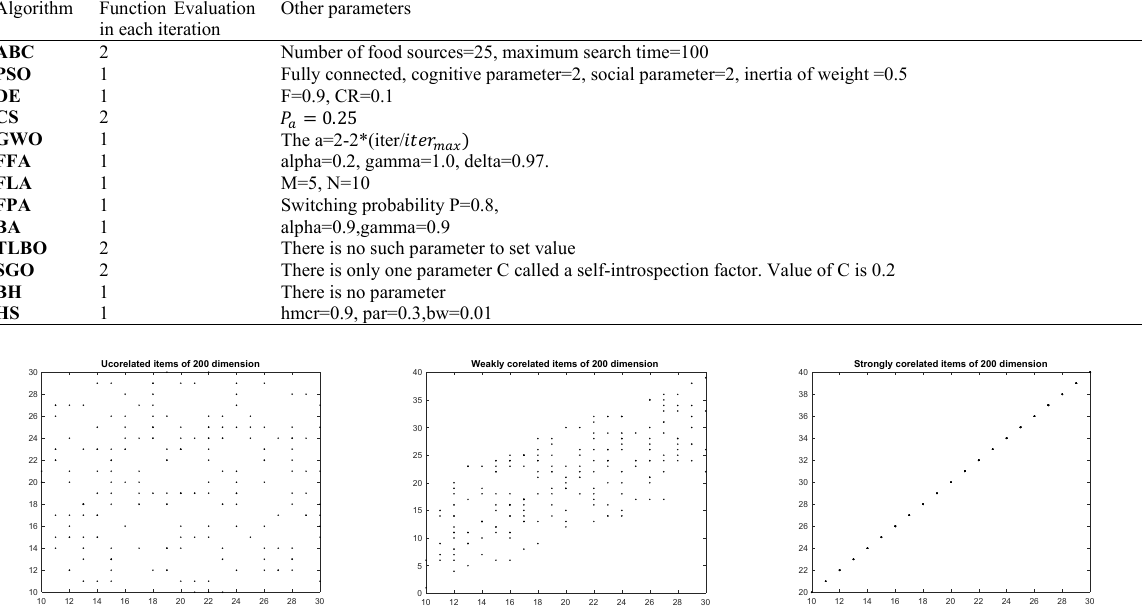
Fig. 2. Nature of uncorrelated items, weakly correlated items and strongly correlated items of